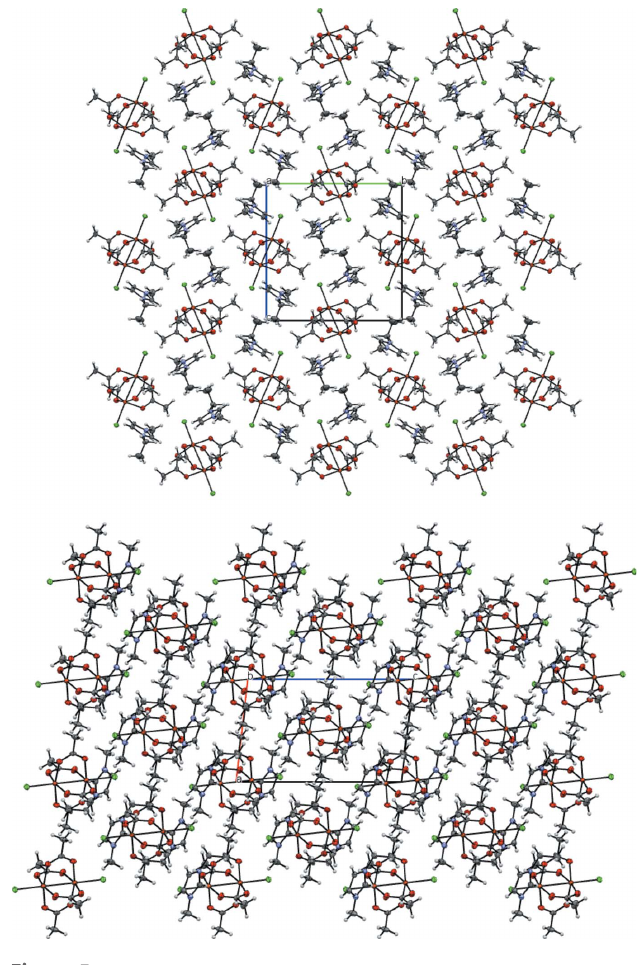
Figure 5 The packing of compound 1 , viewed along the a and b axes.